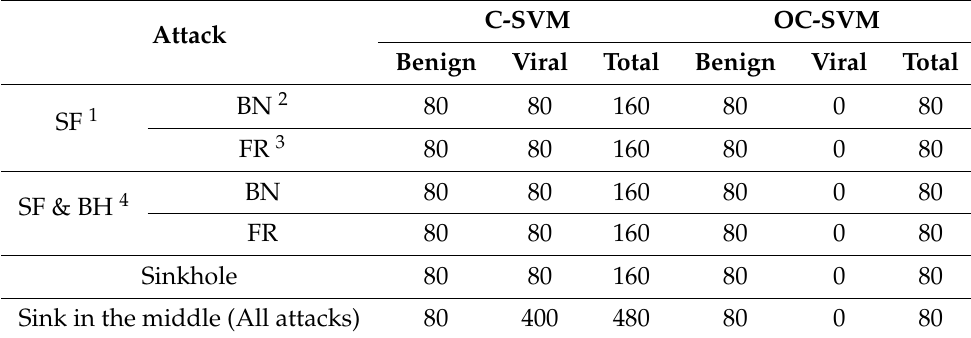
Table 2. SVM training data set when Sink is in the